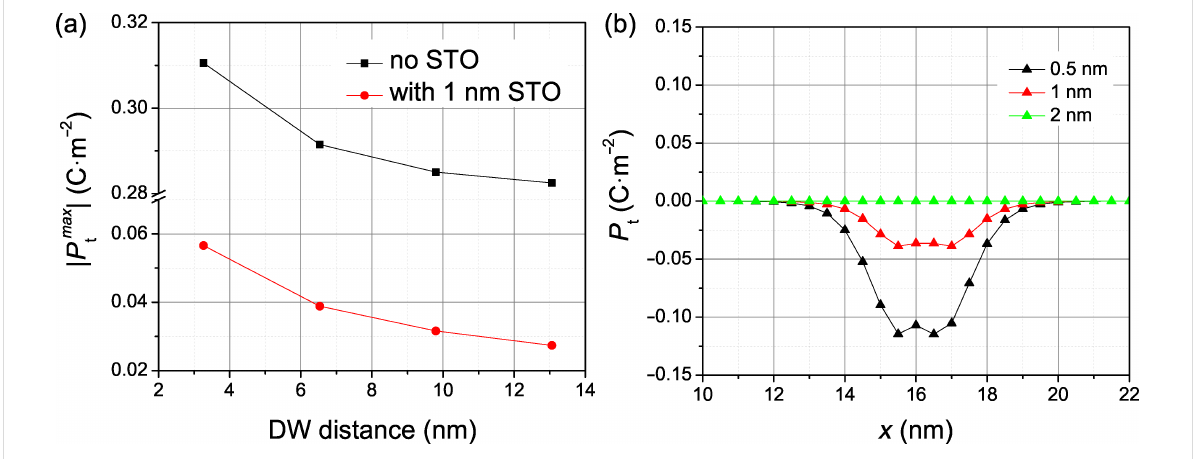
Figure 6: Variation of the P t component (a) with increasing distance between domain walls and (b) with the thickness of the SrTiO 3 layer.